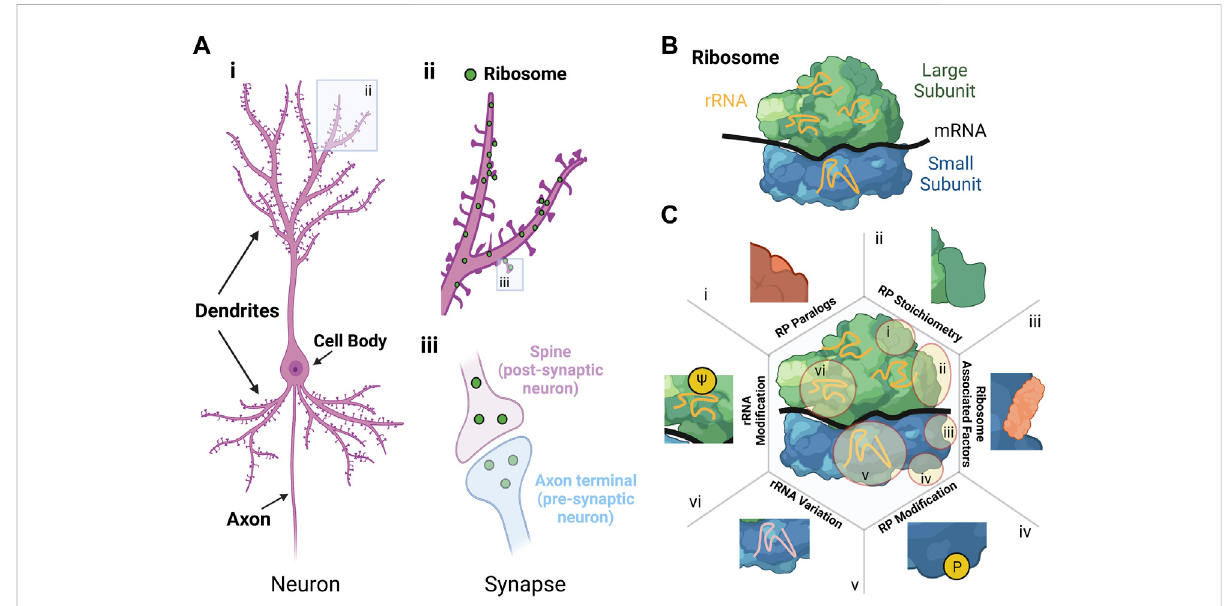
FIGURE 1 Sources and effect of ribosomal heterogeneity in neurons. (A) Morphology of a neuron. i) Schematic of a neuron showing the cell body, dendrites and axon. ii) Close-up schematic of dendrites with ribosomes shown as green dots located both in and adjacent to synapses. iii) Close-up schematic of the synapse with ribosomes shown as green dots in the cytoplasm in both the post-synaptic neuron (i.e., spine in purple) and pre- synaptic neuron (i.e., axon terminal in blue). (B) Structure of the ribosome with the large subunit (green), small subunit (blue), ribosomal RNA (rRNAinorange),andmessengerRNA(mRNAinblack).Forthelargeandsmallsubunit,thedifferentcoloursindicatedifferentribosomalproteins. (C) Schematic showing six sources of ribosomal variation, with illustrative examples of how these changes manifest: i) RP paralogs, ii) RP stoichiometry, iii) Ribosomal associated factors, iv) RP modi fi cation, v) rRNA variation, and vi) rRNA modi fi cation (adapted from (Norris et al., 2021)). Created with